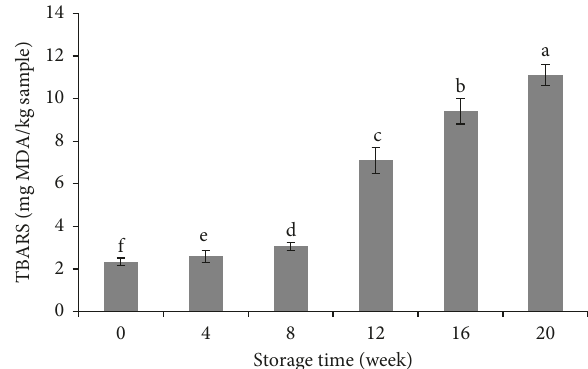
Figure 1: Changes in TBARS value of the Basa fish fillet during frozen storage at − 20 ° C for 20 weeks. Bars represent standard deviation from triplicate determinations. The different letters on the bars indicate significant differences ( p < 0 .